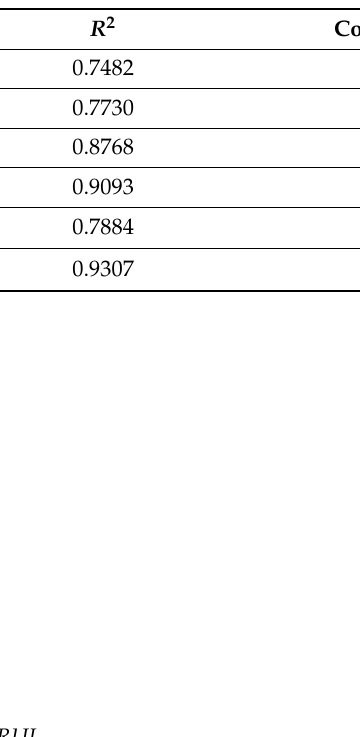
Figure 7. The pair plot for predicted/actual RUL